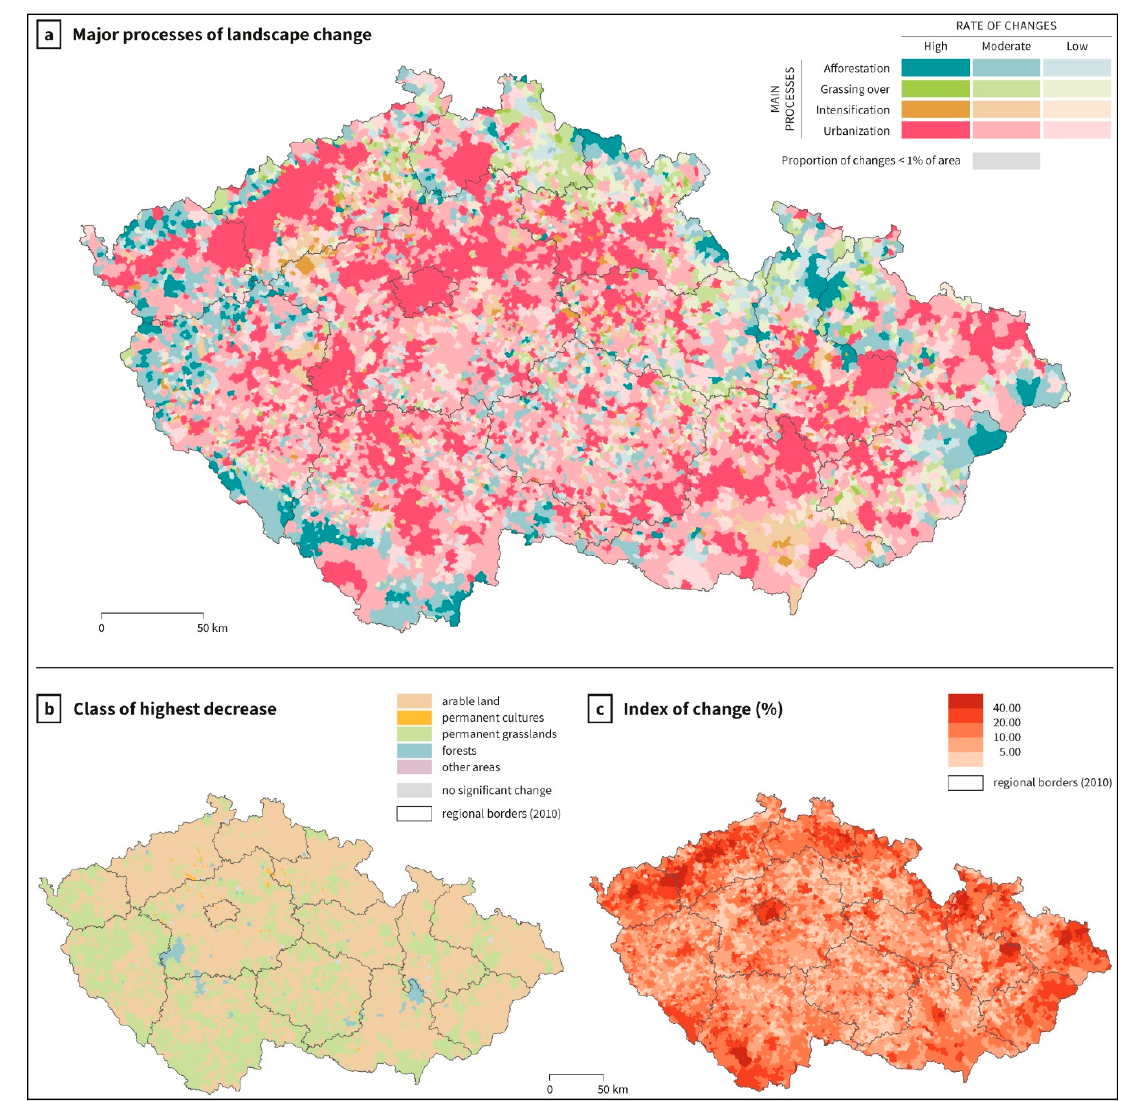
Figure 4. Major processes and intensity of landscape change between 1948 and 1990.